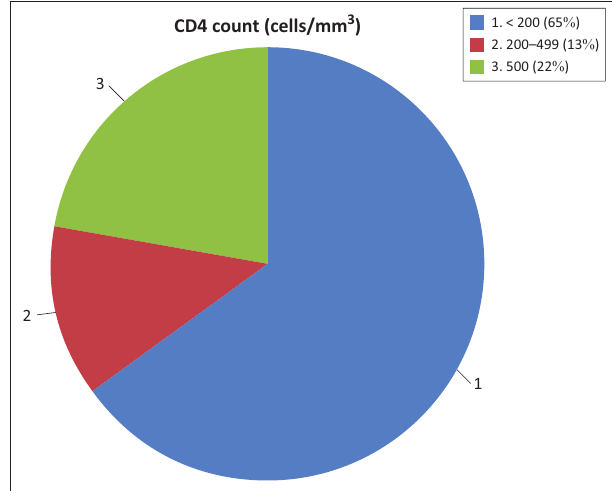
FIGURE 1: Percentage of patients in each CD4 count category according to the CDC CD4 count classification.